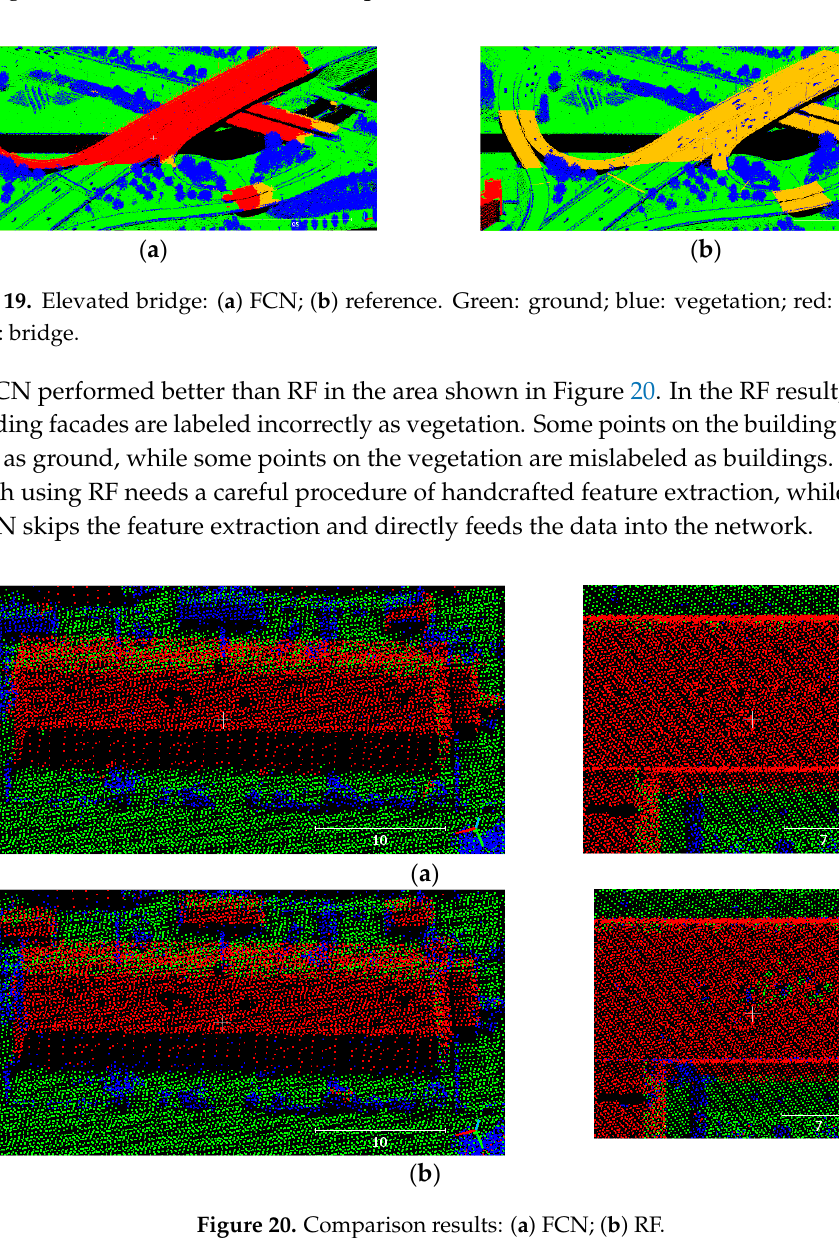
Figure 20. Comparison results: ( a ) FCN; ( b ) RF.